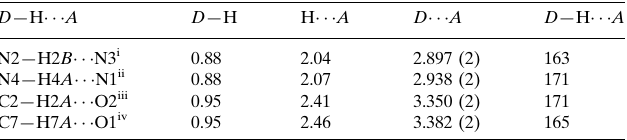
Hydrogen-bond geometry (A˚ , (cid:2)